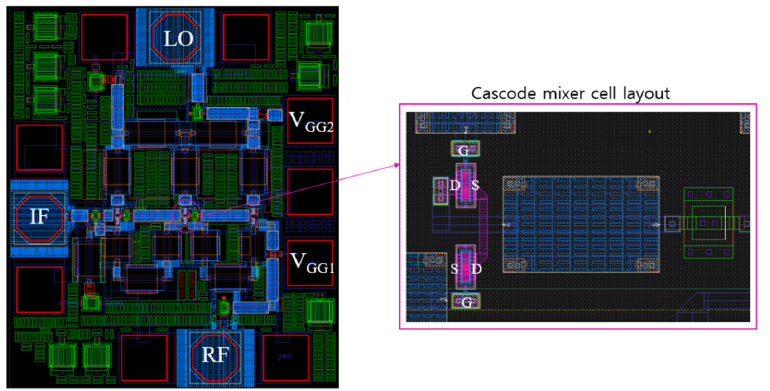
Figure 12. Layout of distributed cascode mixer.